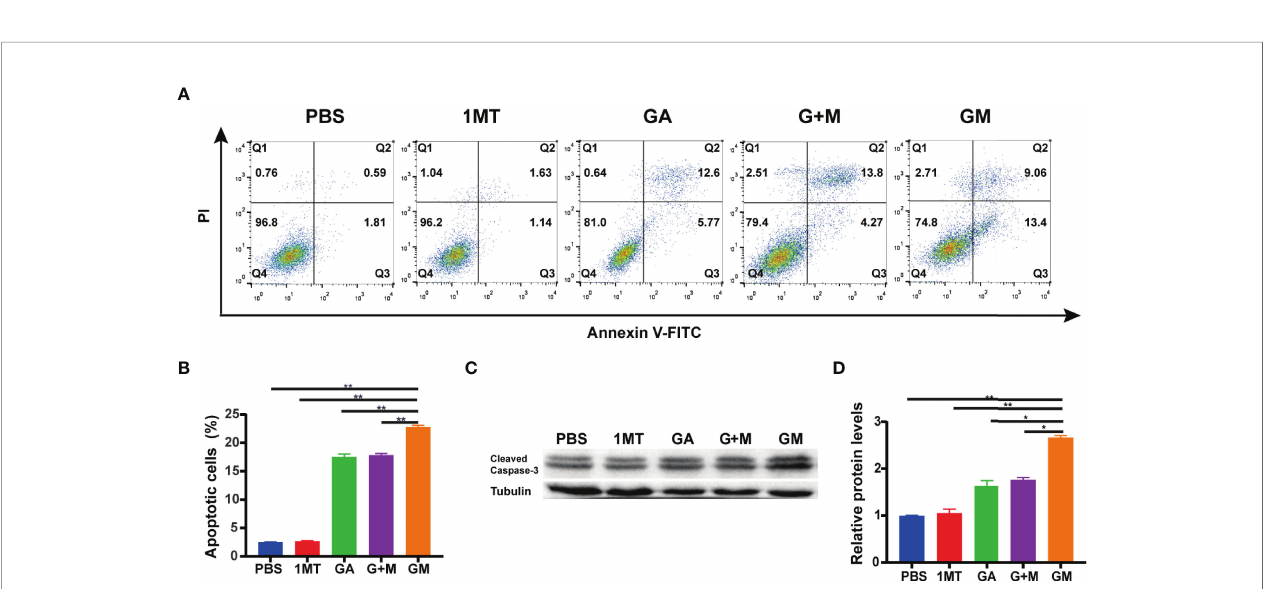
FIGURE 2 | GM induced the apoptosis of B16F10 cells in vitro . (A) The apoptosis ratio was measured using Annexin V-FITC/PI apoptosis detection kit in B16F10 cells after the different treatments and the quantitative analysis (B) . (C) The expression of cleaved caspase-3 was detected by Western blot with different drugs, and their average gray values were quanti fi ed (D) . Data are presented as means ± SD, n = 3, *p < 0.05, **p < 0.01.